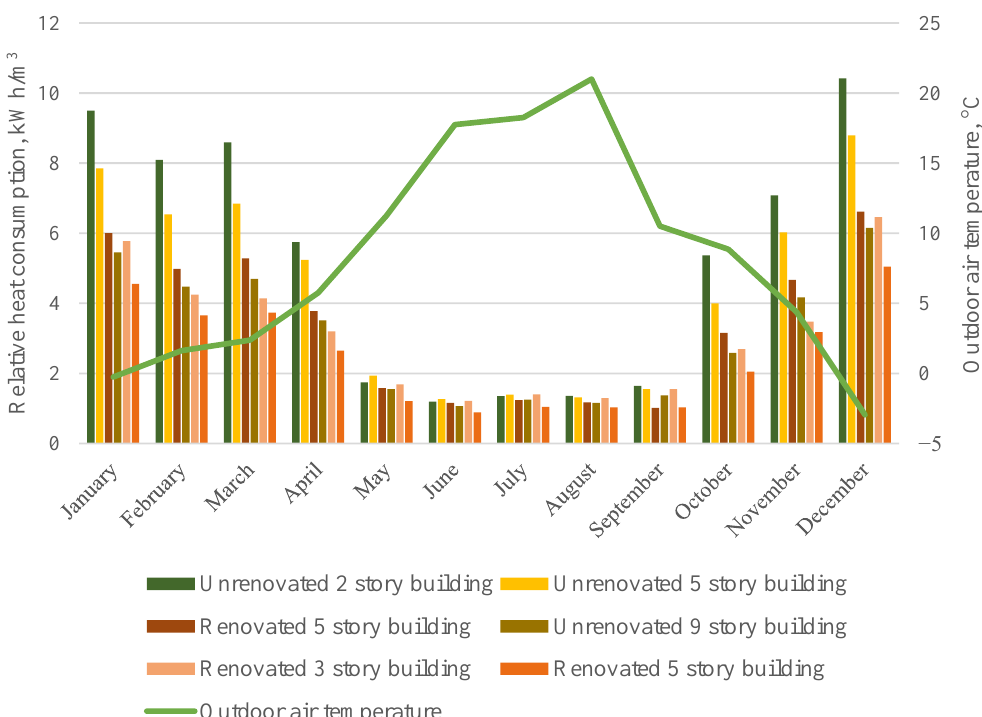
Figure 2. Comparison of relative heat consumption in renovated and unrenovated apartment buildings.